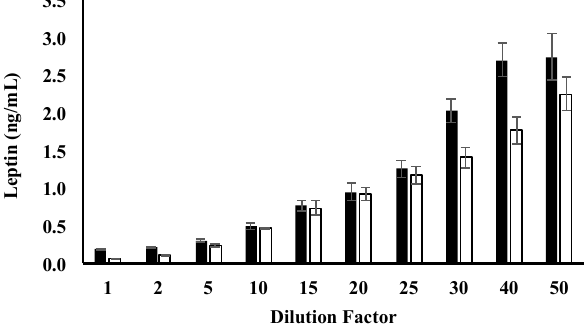
Figure 2. Leptin concentration for whole and skim human milk for each dilution tested. Values are mean ± SEM ( n = 100 diluted human milk preparations). Leptin levels in whole and skim human milk are shown by black and white bars, respectively.